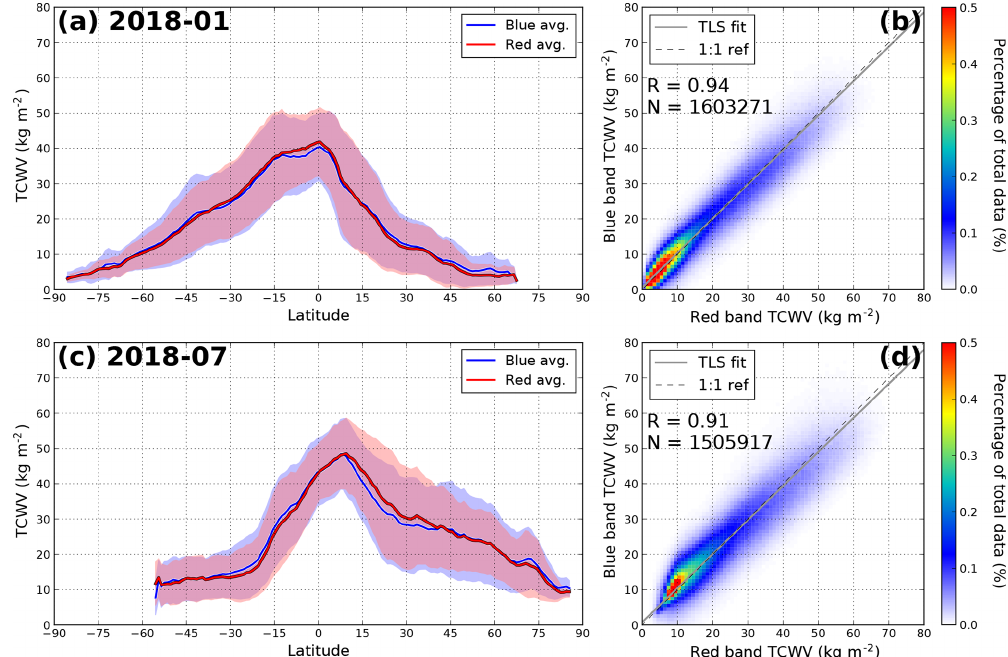
Figure 8. Comparison of TCWV from the blue retrieval and operational algorithm. (a) Zonal and (b) direct comparison in January 2018. Panels (c) and (d) are the same as panels (a) and (b) for July 2018. The shadings in the zonal average plots indicate the 1 σ standard deviation variation range. The color code of the scatterplots indicates the relative portion of total measurement pixels. Individual GOME-2A measurements are used in the